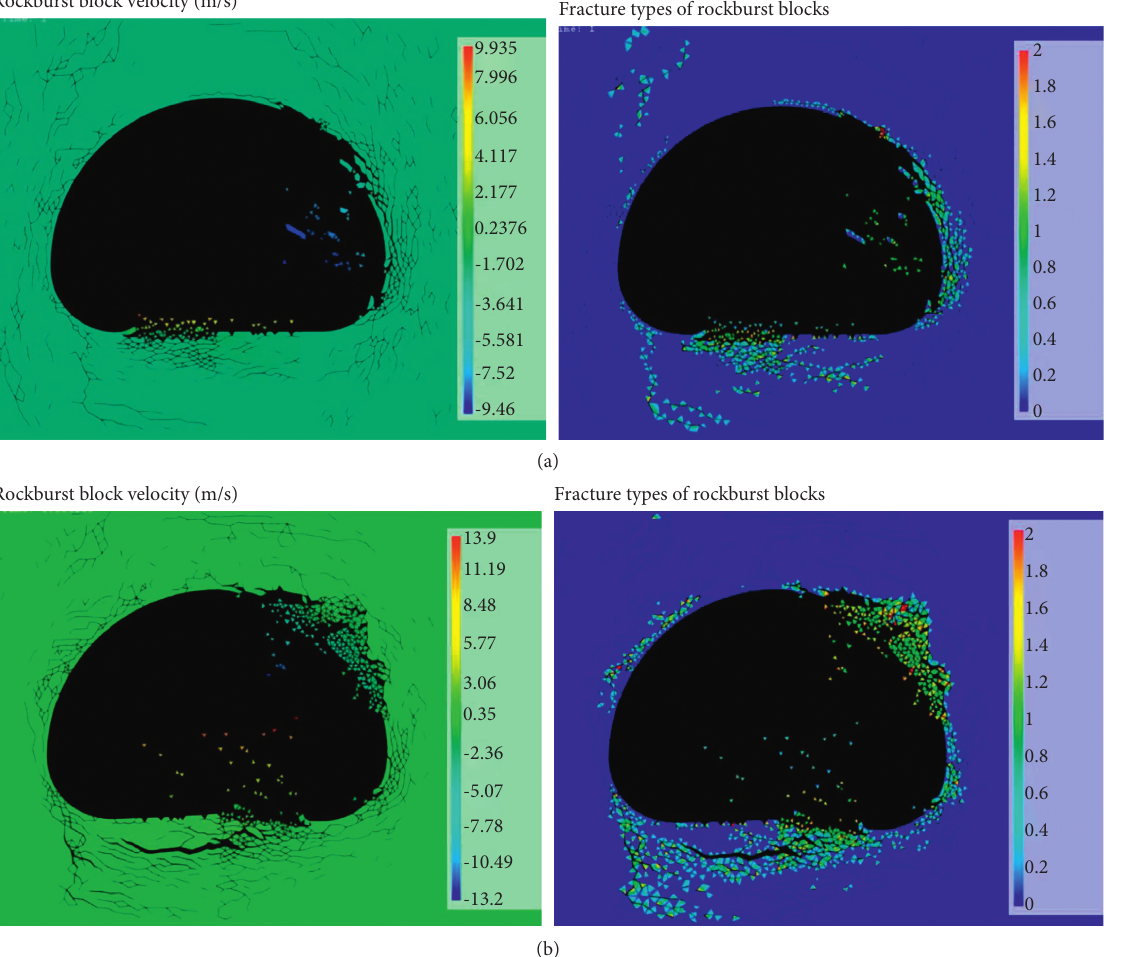
Figure 12: Simulation and comparison of rockburst disasters (discontinuous model): (a) weak support stiffness; (b) strong support